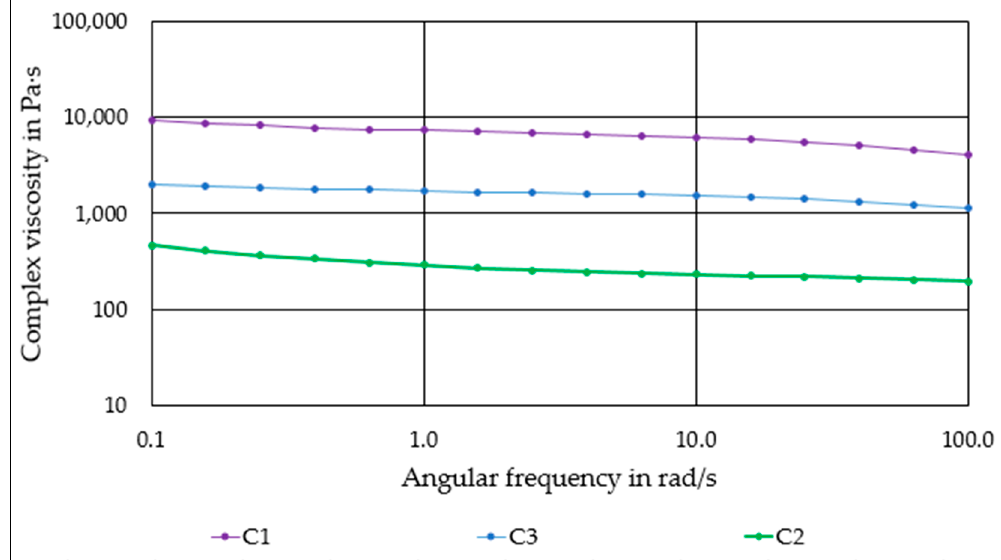
Figure 2. Complex viscosity of the produced compounds as a function of the angular frequency.